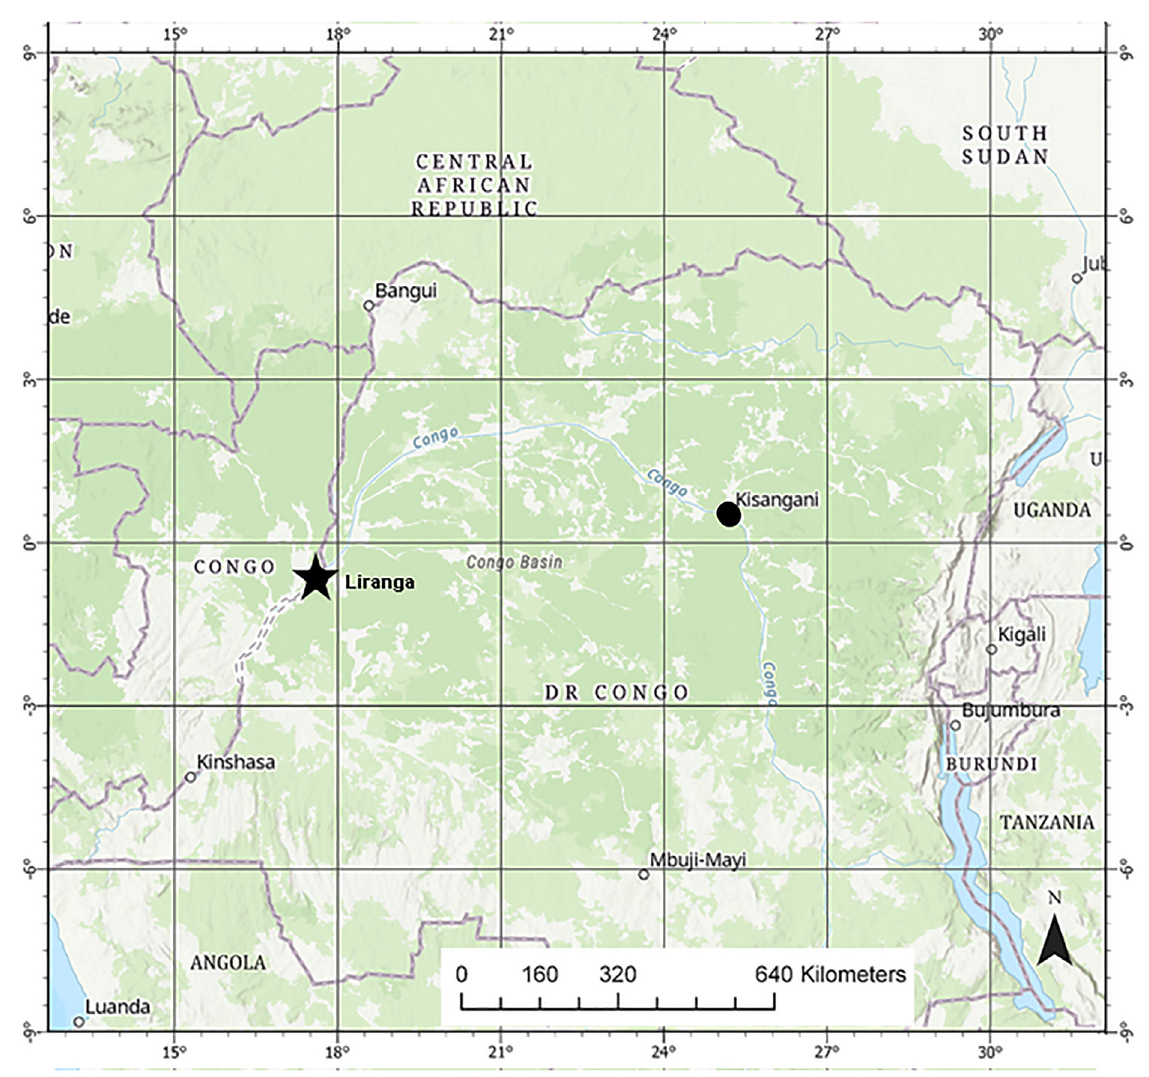
Fig. 1. Map showing the updated geographic distribution of Potamonautes lirrangensis (Rathbun, 1904) s. str. The black star on the left is Liranga, République du Congo (MNHN B-3826), the type locality. The black circles show the distribution of Potamonautes kisangani sp. nov. in the vicinity of Kisangani, D.R. Congo. See text for exact